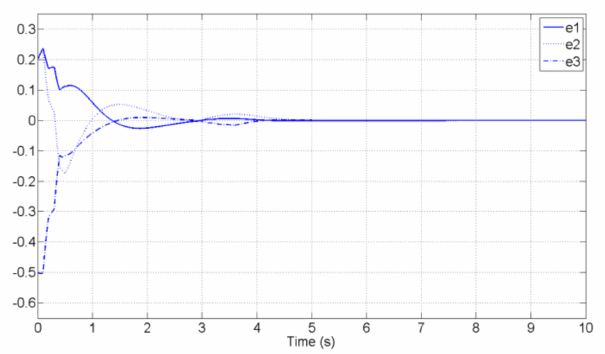
Figure 7. The estimated error of the